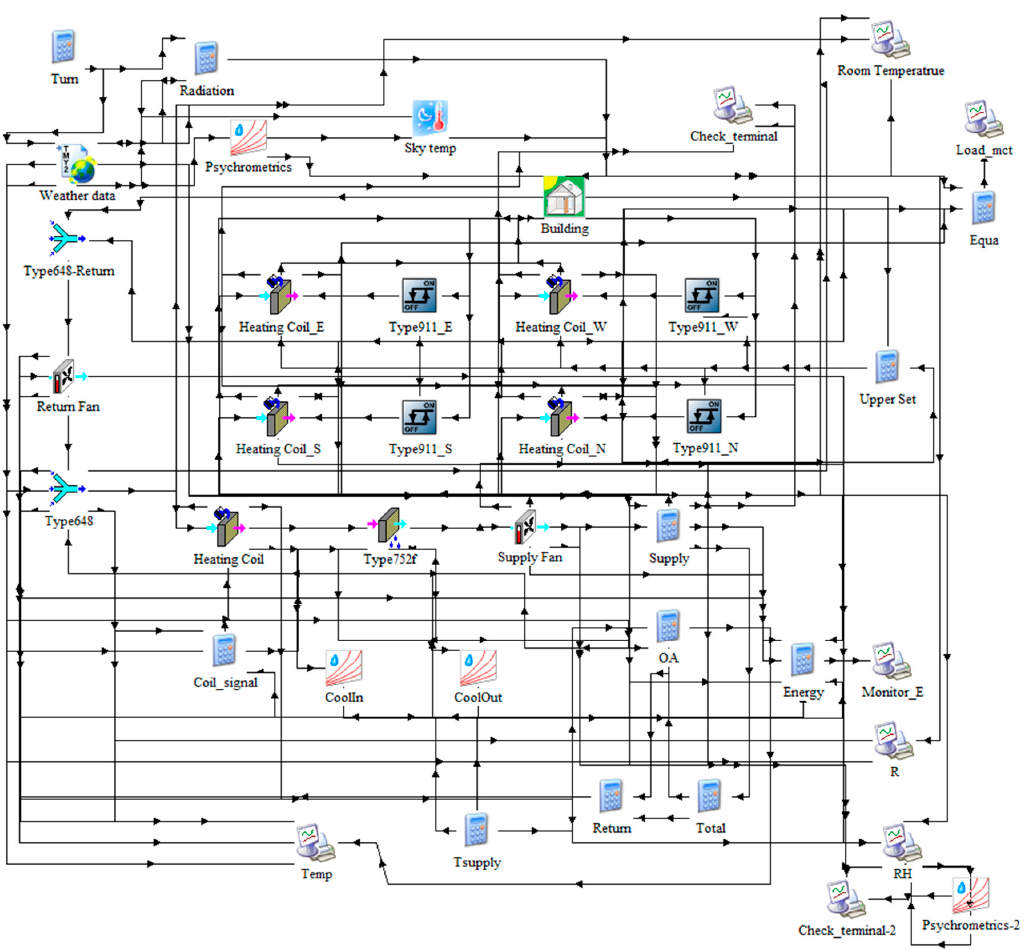
Figure 6. Modeling of the target building system using simulation studio.